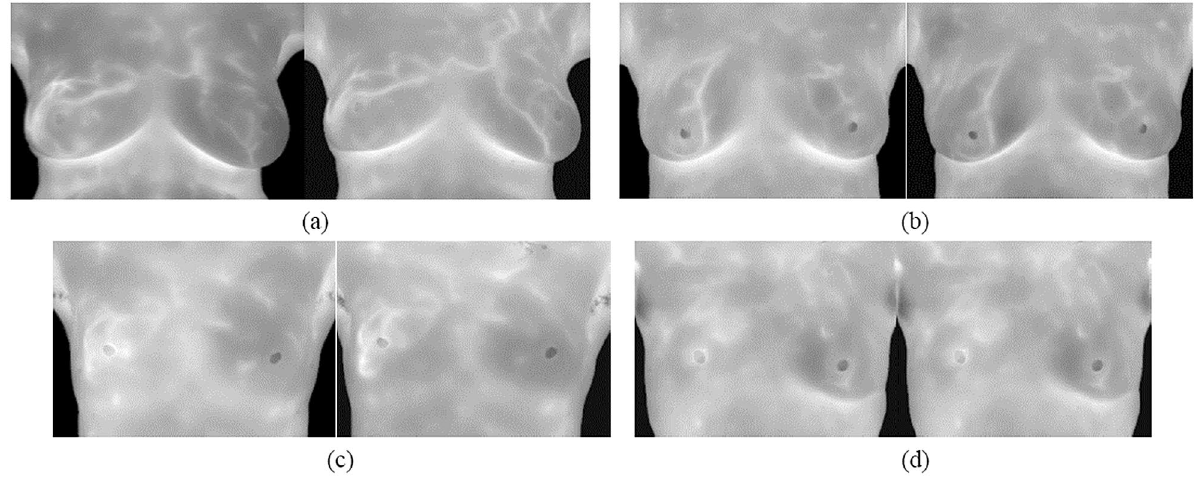
Figure 1. Results of four registration situations: ( a ) TYPE I, ( b ) TYPE II, ( c ) TYPE III, and ( d ) TYPE